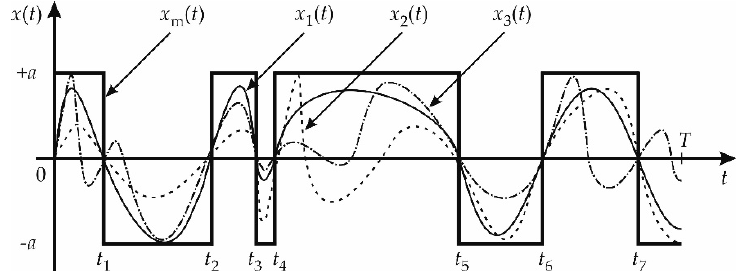
Figure 3. Examples of the limited signal and other signals contained in its limitation.